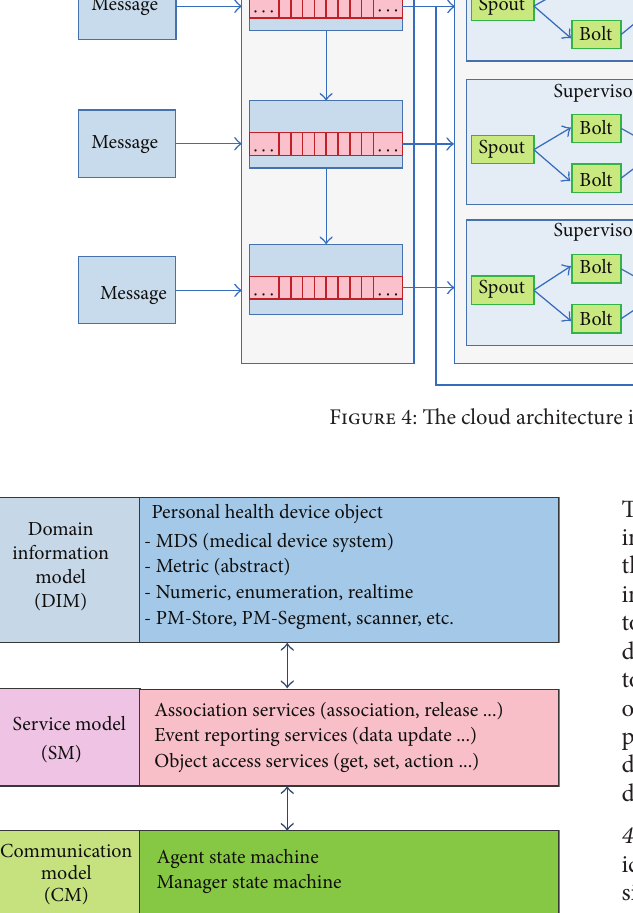
exchange protocols, and interface protocols. The X73 protocol stack of a sensor node is shown in Figure